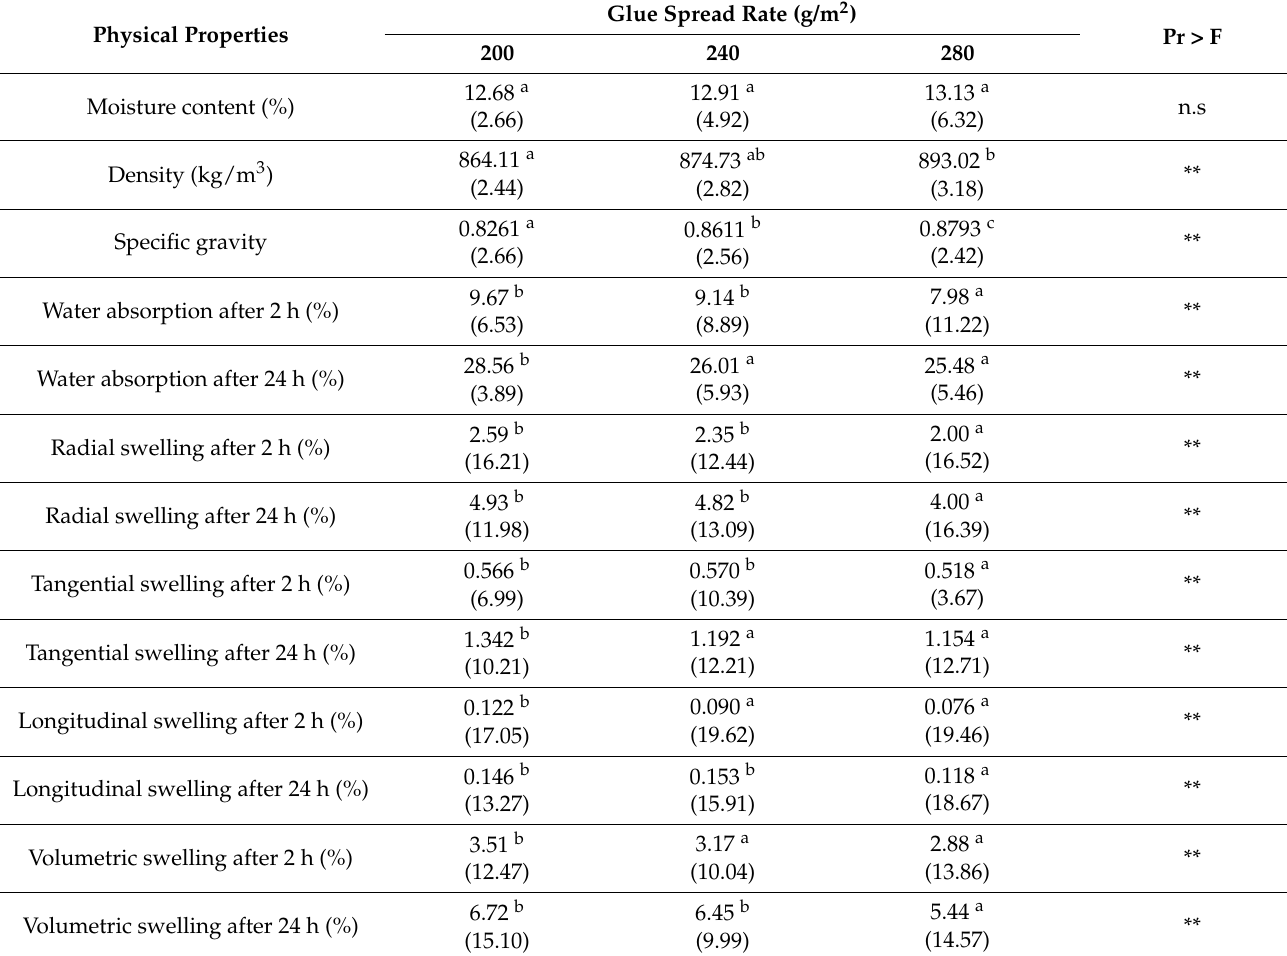
Table 3. Mean values of physical properties of rubberwood LVL produced using different glue spread